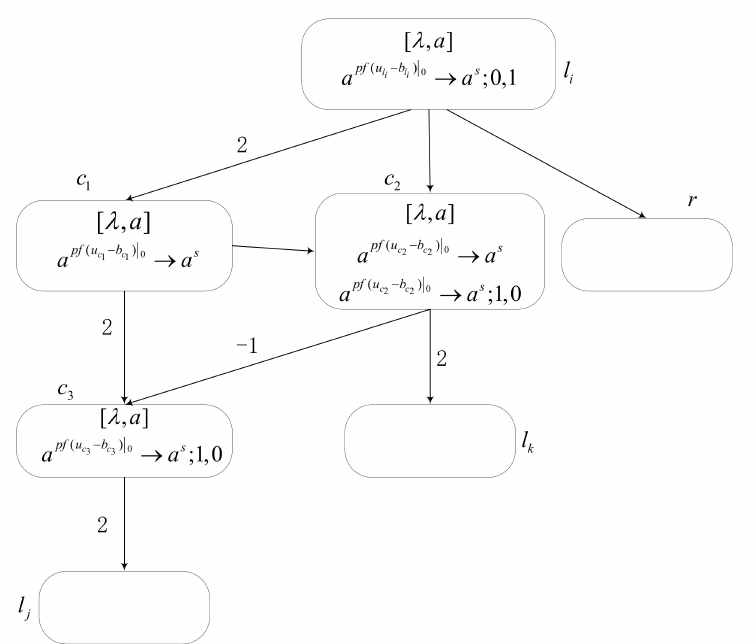
Figure 5. Module ADD. Its function is to Simulate ADD instruction l i : ( ADD ( r ) , l j , l k ) . (1) If the rule a pf ( u 2 − b 2 ) | 0 → a s is applied, neuron σ c one spike at time t + 2. The configuration becomes C t + 2 ≤ 0, 1, 2, 1, 1, 1, 0, 1, 0, 1, 0, 1 >